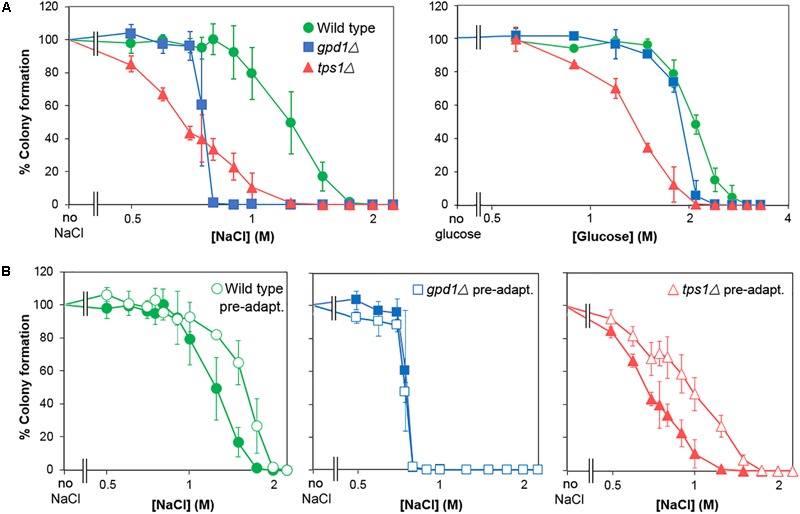
GPD1 but not TPS1 is required for heterogeneity of resistance to chronic salt and glucose stresses. (A)
S. cerevisiae BY4741 or isogenic deletion strains Δgpd1 or Δtps1 were spread on YEPD agar containing increasing levels of salt (NaCl) (left panel) or glucose (right panel). Colonies were enumerated after 28 days incubation at 25°C. (B) Organisms cultured as in (A) were pre-treated for 1 h with 0.5 M salt before spreading to YPD agar containing increasing levels of salt. Colonies were enumerated after incubation for 28 days at 25°C. Data are means and SDs from triplicate cultures.